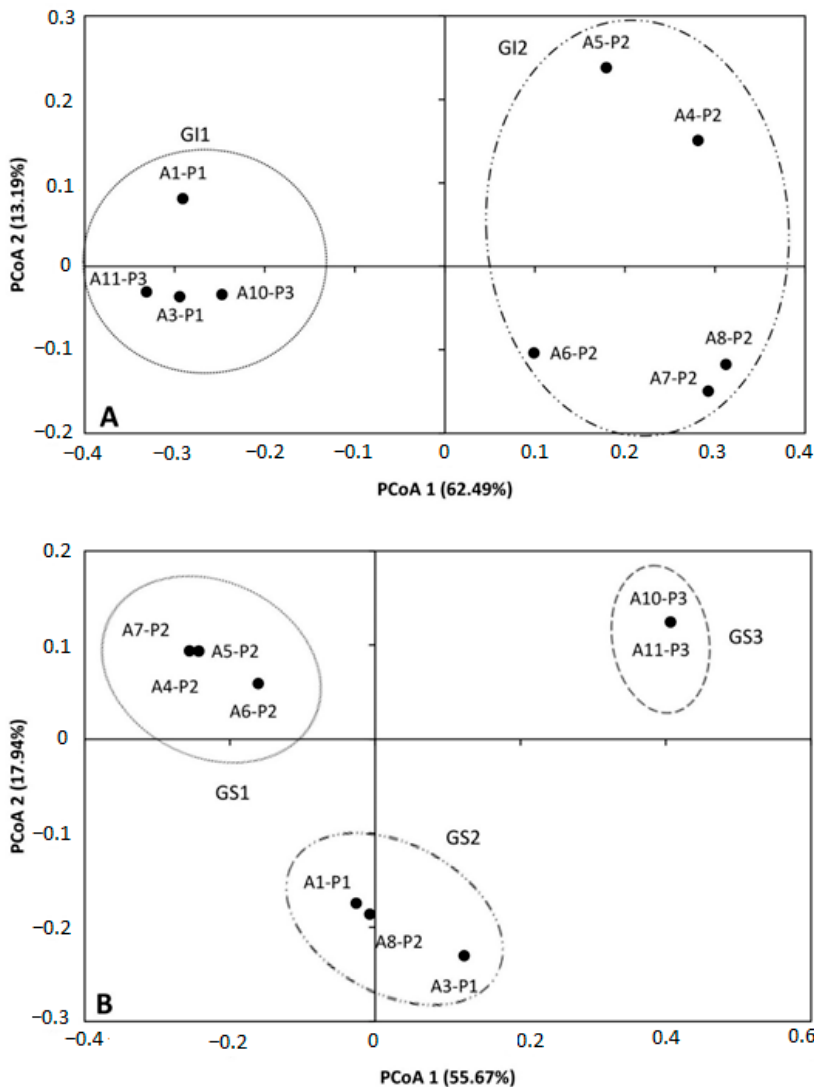
Figure 5. Principal Coordinates Analysis (PCoA) obtained by the complement of Jaccard Index for ISSR data ( A ) and by the complement of weighted index for SSR data ( B ) for Hancornia speciosa genotypes collected in Montes Claros (A1-P1 and A3-P1), Caçu (A6-P2, A7-P2, A8-P2, A4-P2 and A5-P2), and Ouroana (A10-P3 and A11-P3). The dotted lines highlight the clusters formed by GI1 e GI2 using ISSR data ( A ) and GS1, GS2, and GS3 for SSR data ( B ). According to the PCoA using ISSR markers, two clusters were discemed: (i) GI1 con-